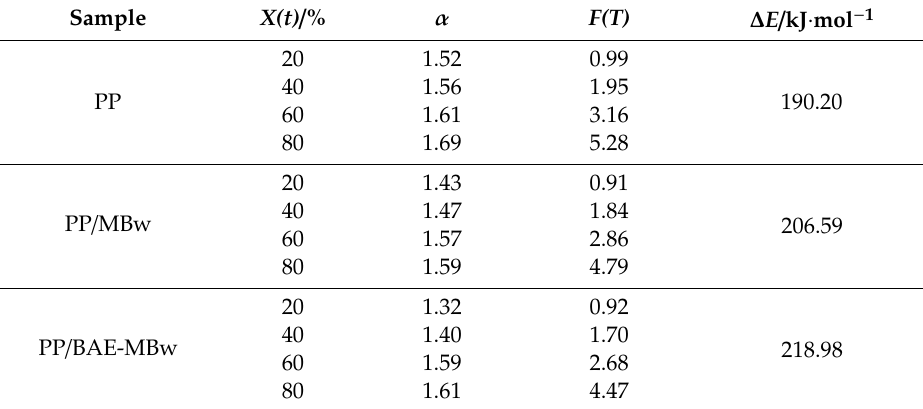
Figure 5. Plots of lg  versus lg t for PP and its composites at different relative degrees of crystallinity. ( a ) PP, ( b ) PP/MBw, and ( c ) PP/BAE-MBw.